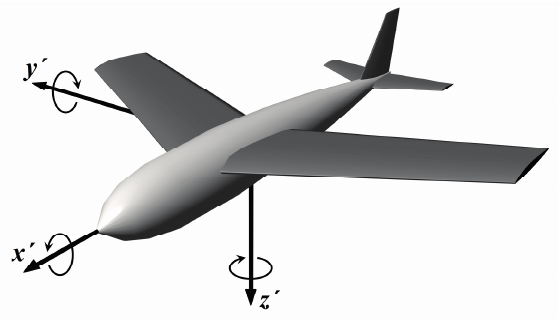
Figure 1. Orientation of the coordinate system